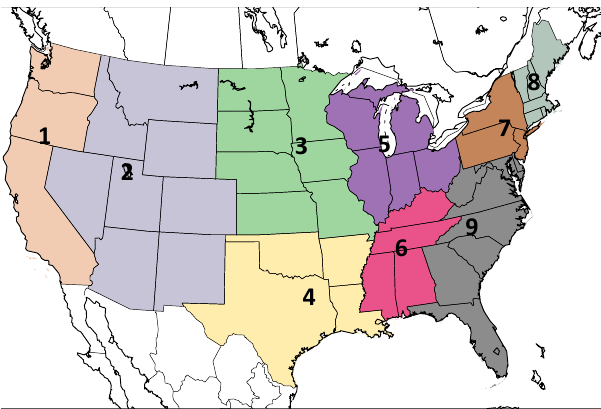
Figure 5. Nine regions defined by the US Census Division, over which we aggregate our fossil fuel CO 2 flux estimates (www.eia.